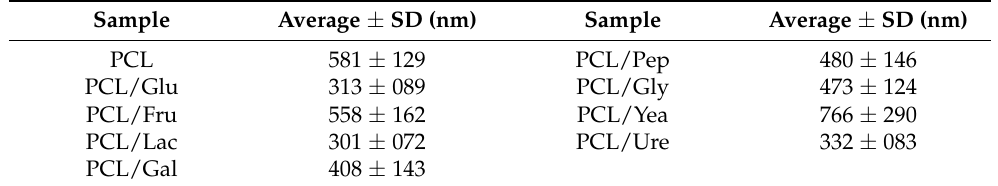
Table 4. Average fiber dimeter with standard deviation (SD) for PCL, PCL/Cs and PCL/Ns fibers. Sample Average ± SD (nm) Sample Average ± SD (nm) PCL 581 ± 129 PCL/Pep 480 ± 146